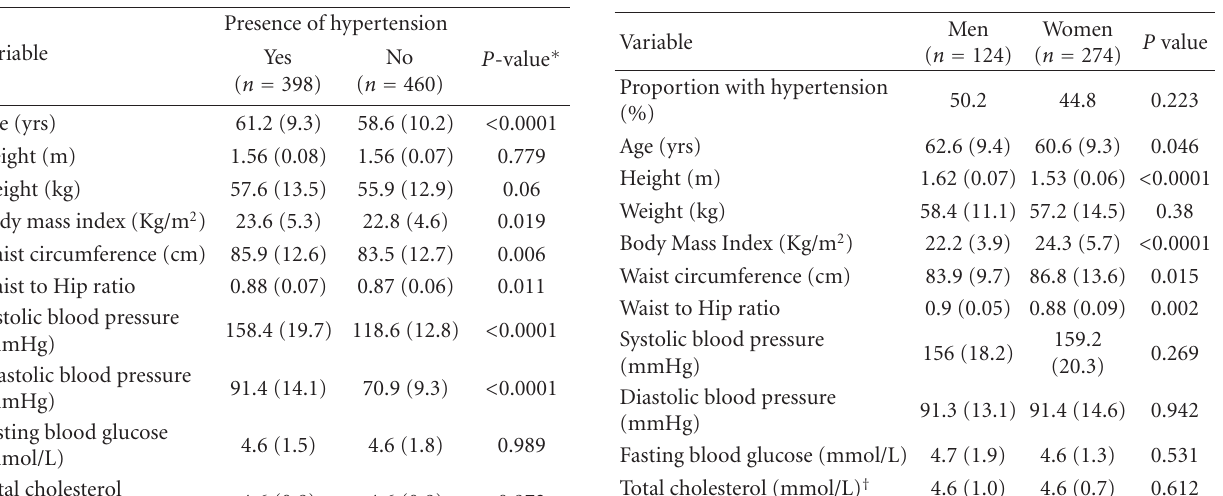
Table 2: Clinical Characteristics of the hypertensive subjects by gender.